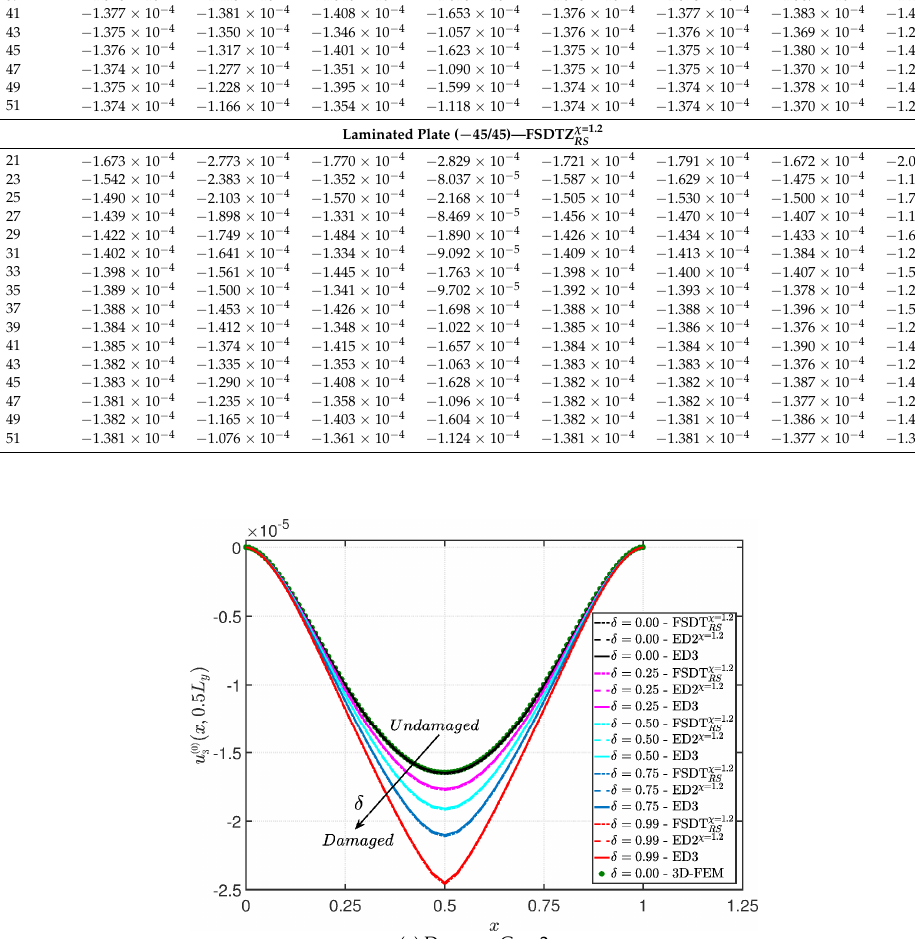
( b ) Damage: Gau-3 Figure 6. Evaluation of the central vertical displacement profile [m] for the completely clamped boundary conditions (CCCC) isotropic square plate varying the mechanical parameters of the damage: ( a ) Gau-2; ( b ) Gau-3. The results are obtained by means of several Higher-order Shear Deformation Theories (HSDTs). As expected, the displacements increase when the damage grows or when it involves a bigger area of the domain. The results are compared with the solution obtained with a finite element commercial software (Strand 7) for the undamaged case, by using a three-dimensional model (3D-FEM). The profiles in hand are shown in the graphs through a dotted notation and match perfectly with the corresponding GDQ curves. The through-the-thickness variations of strain, stress, and displacement components are presented in Figures 7–9 for the Gau-2 damage model, whereas